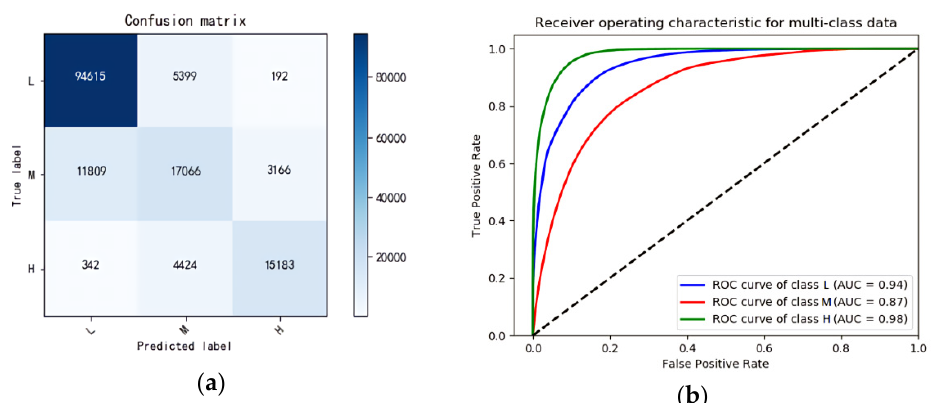
Figure 8. ( a ) Confusion matrix of the random forest; ( b ) ROC curves of the random forest.